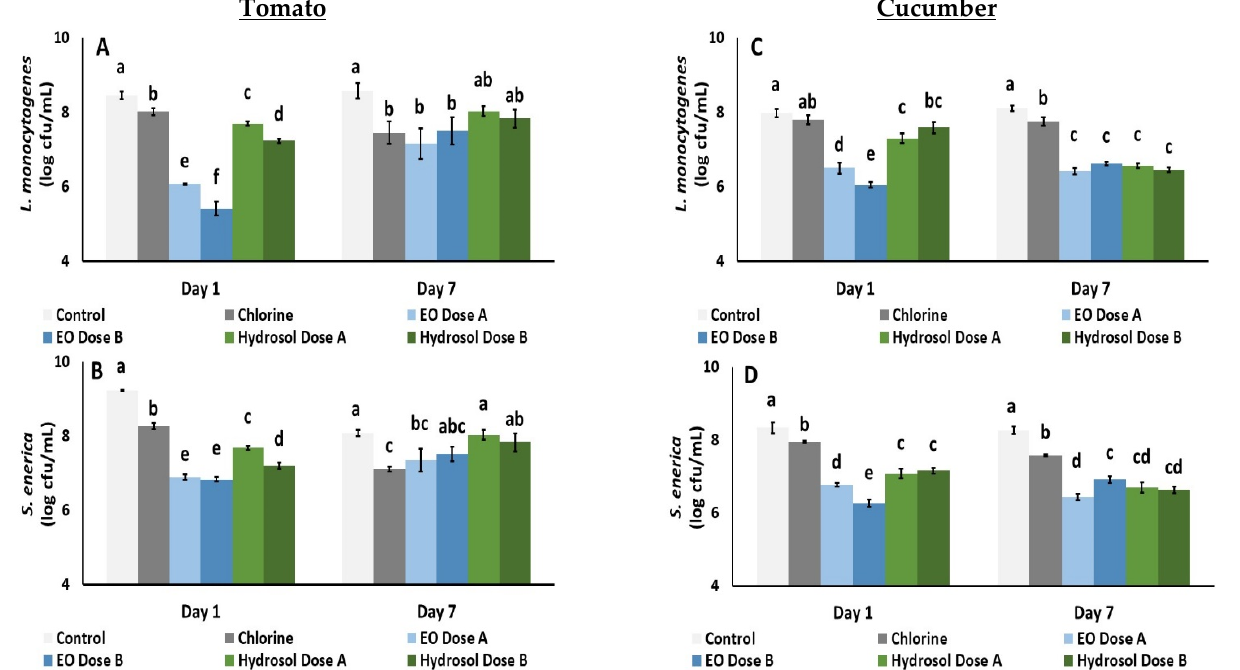
Figure 5. Effects of sanitation means, i.e., chlorine (0.02%), O. dubium EO dose A (0.01% for 10 min), EO dose B (0.1% for 10 min), hydrosol dose A (0.1% for 20 min) and hydrosol dose B (0.5% for 20 min) on tomato ( A , B ) and cucumber ( C , D ) fruits stored 11 °C and inoculated with Listeria monocytogenes and Salmonella enterica , respectively. Bars represent the mean ± standard error of four biological replicates per treatment. On each day, significant differences ( p < 0.05) among treatments are indicated with different Latin letters.